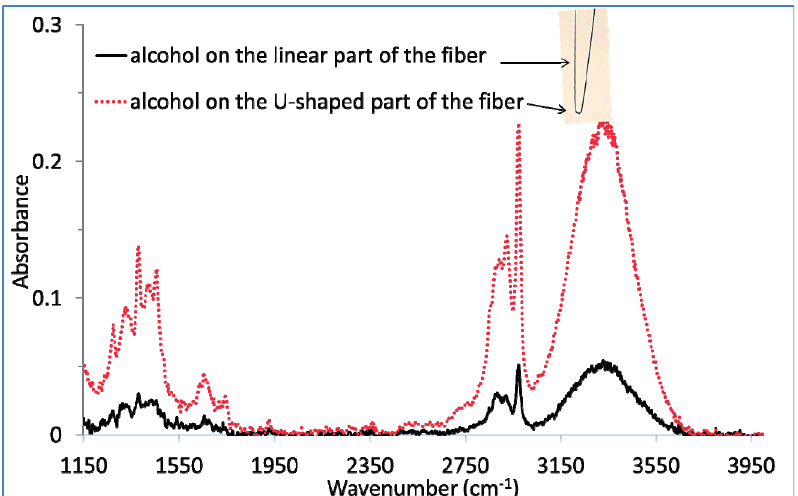
Figure 4. Comparison between two alcoholic solution spectra depending on the position of the drops, on the U-turn or on the linear transportation